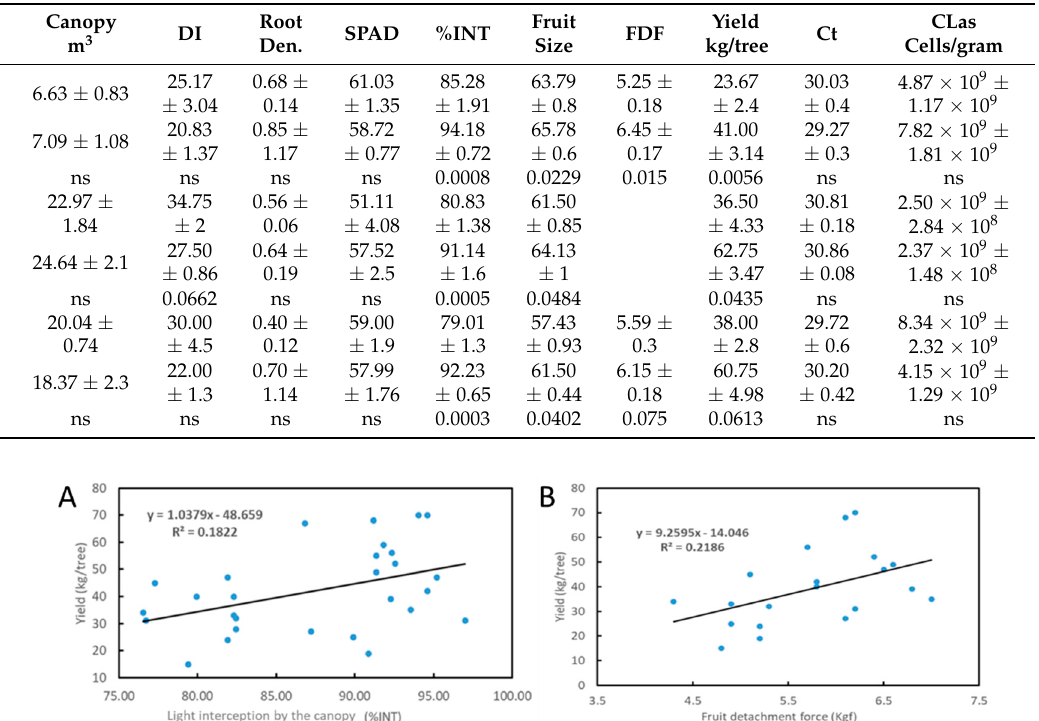
Figure 2. Correlation between yield and photosynthetically active radiation interception percent in the canopy (%INT; ( A )) or fruit detachment force ( B ) . the canopy (%INT; ( A )) or fruit detachment force ( B